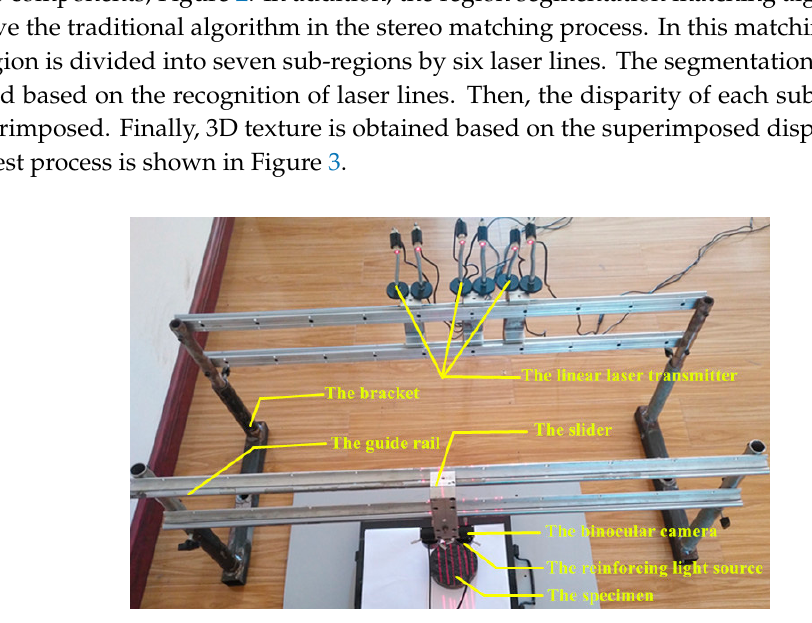
Figure 2. The improved binocular reconstruction test system.